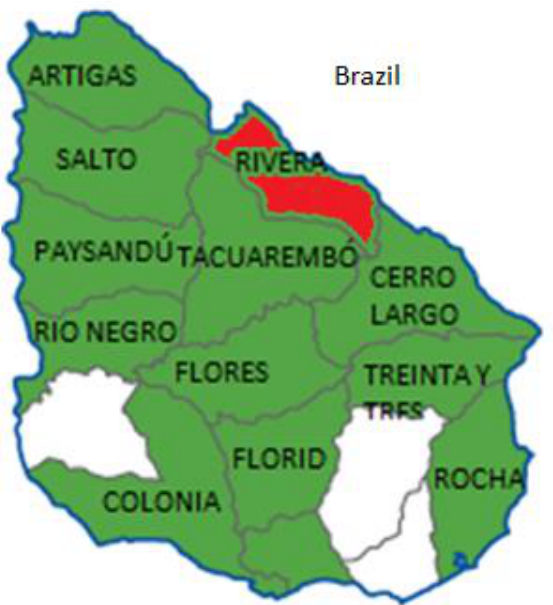
Figure 1. Territories of the ART Uruguay Local Development Program—Department of Rivera. Source: (Programa de Naciones Unidas para el Desarrollo 2012), p. 56.